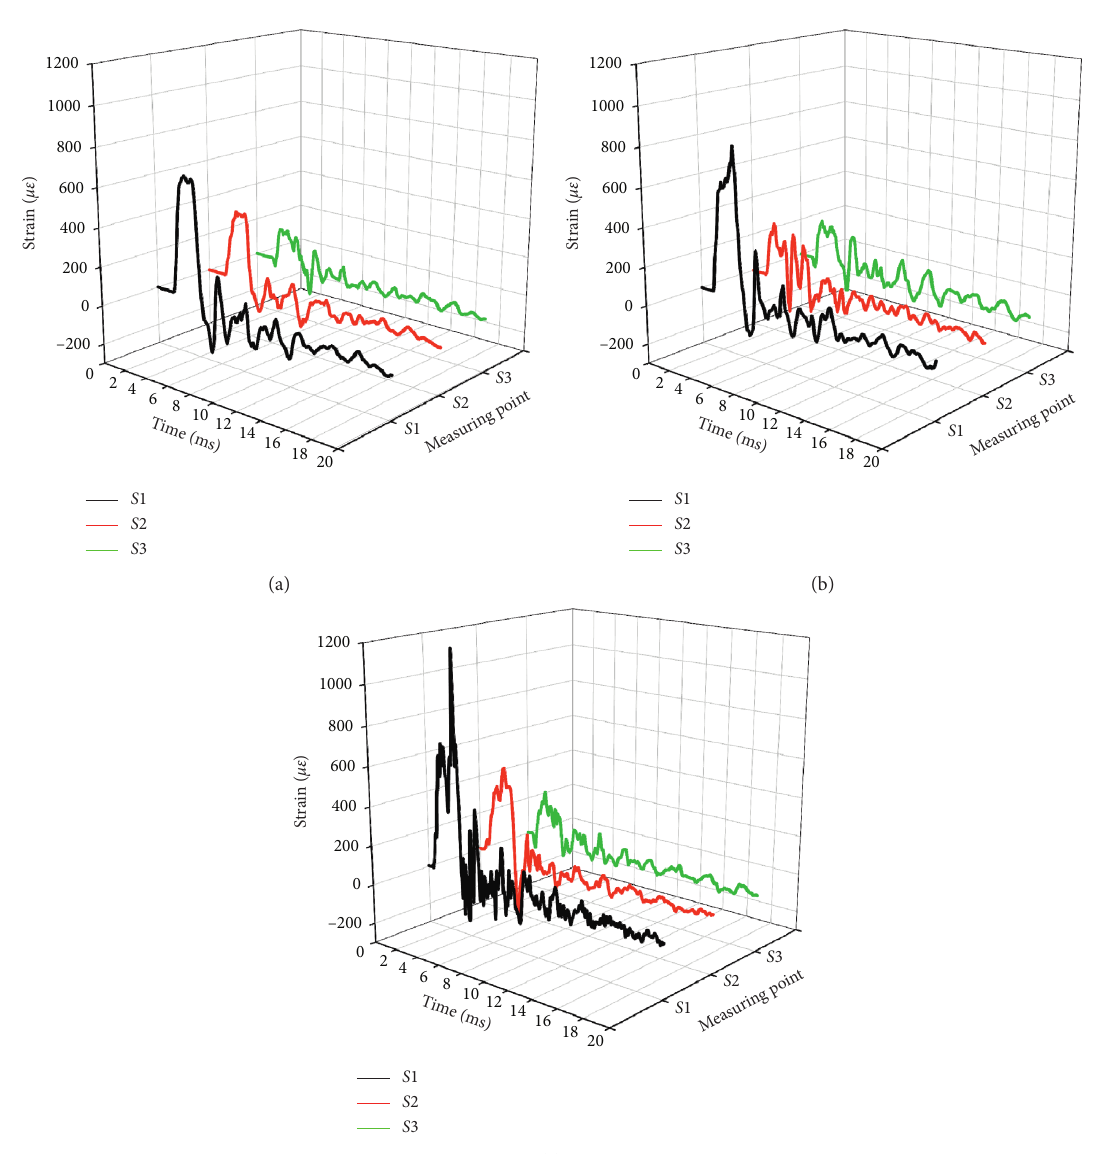
Figure 7: Time-history curve of strain response of bottom plate under different porosity under test. (a) 80%. (b) 85%. (c) 90%.